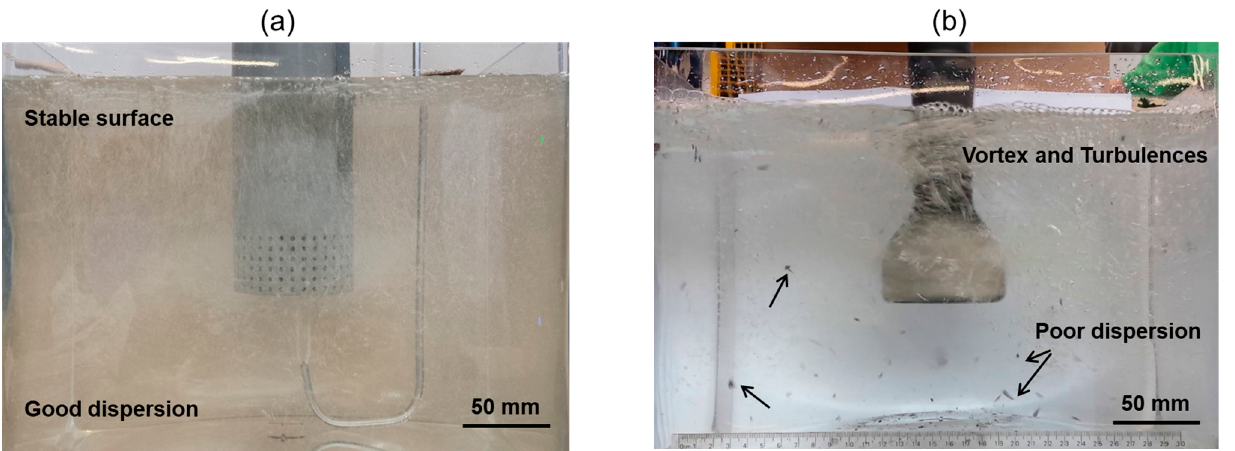
Figure 2. Visualization in water of ( a ) HSMC degassing (1000 rpm, 0.5 L/min), offering distributive and dispersive mixing and stable fluid surface. ( b ) Rotary degassing (350 rpm, 5 L/min) offers only distributive mixing, poor dispersion, and vortex surface turbulence. The black arrows indicate the presence of non-dispersed particles in the liquid.